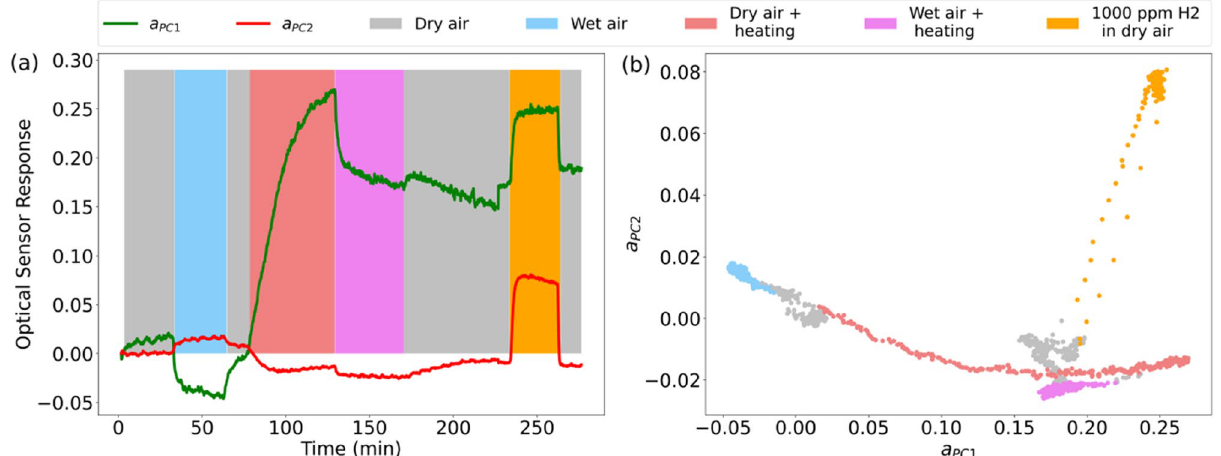
Figure 6. ( a ) Response of the as-deposited sensor in terms of the first ( a PC 1 , green) and second. ( a PC 2 , red) principal components measured at different conditions and ( b ) a corresponding diagram of a PC 1 vs. a PC 2 . Responses to wet air (blue) with 30% RH, to heating up to 60 °C (pink), to both humidity and heating simultaneously (magenta), and to 1000 ppm of hydrogen in dry air at room temperature (orange) are